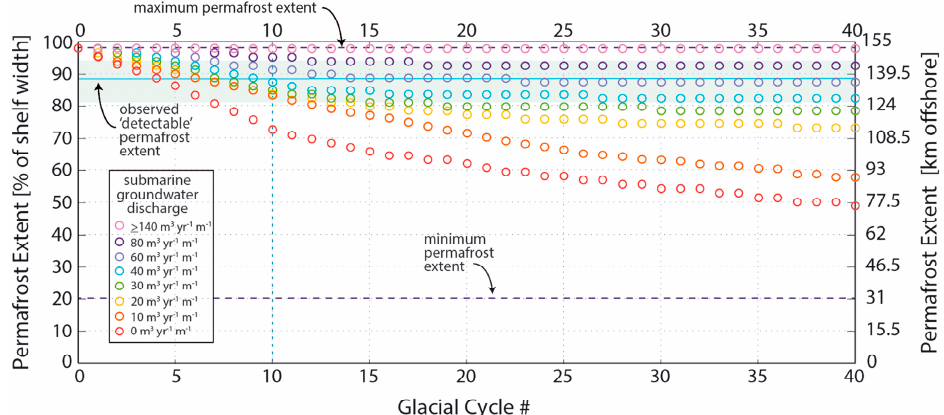
Figure 4. Modeled permafrost extent (y-axis) with time (x-axis, Glacial Cycle) at different fluxes of submarine groundwater discharge (SGD) from Frederick and Buffet [10]. 40 glacial cycles are equivalent to 40,100 ka. The higher the submarine groundwater flux, the more extensive the permafrost extent remains over time. With all simulations beginning at 100% permafrost extent, by the end of the simulations, no SGD resulted in a permafrost extent of 50% of the shelf width, whereas the highest SGD flux of > 140 m 3 year − 1 m − 1 maintained permafrost extent at 100% of the shelf width. Reprinted with permissions.